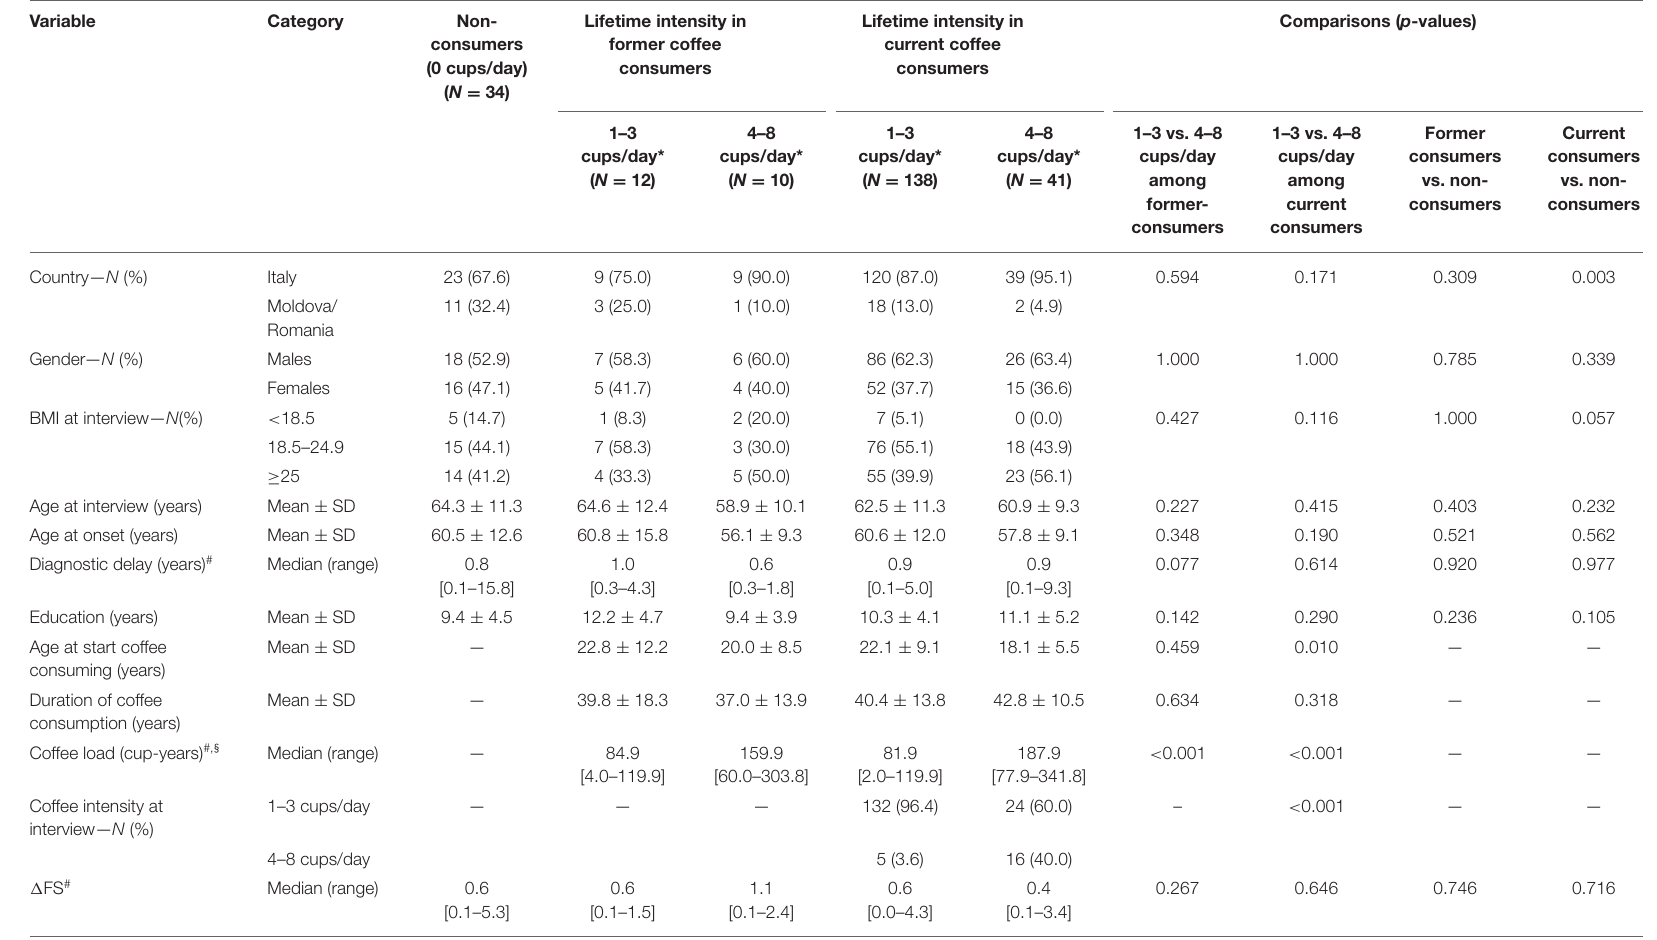
TABLE 2 | Clinical variables according to coffee consumption status (i.e., none vs. former vs. current consumers) and lifetime intensity of coffee consumption (i.e., mean daily cups per day